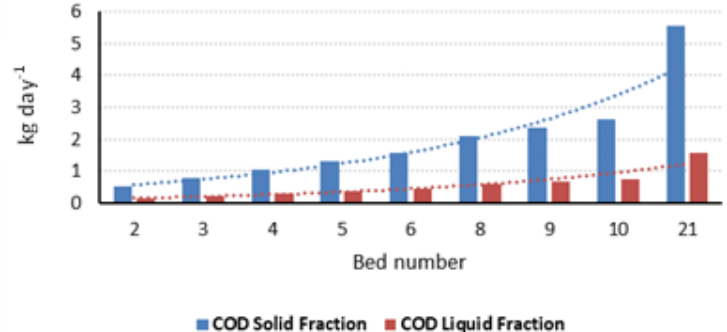
Figure 4. COD values for solid and liquid fraction.